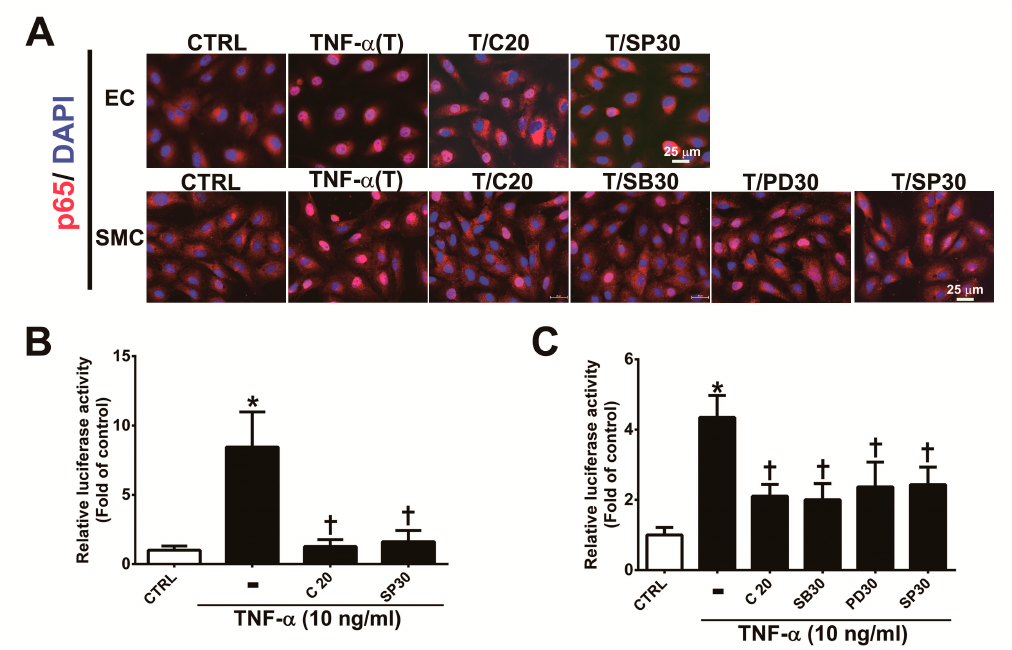
Figure 5. Corylin reduces the activation of NF- κ B p65 in TNF- α -treated HUVECs and VSMCs. ( A ) HUVECs were pretreated (1 h) with 20 µ M corylin (C20) or 30 nM SP600125 (SP30) and then incubated with 10 ng / mL TNF- α (T) for 15 min. VSMCs were pretreated (1 h) with 20 µ M corylin, 30 µ M SB203580 (SB30), 30 µ M PD98059 (PD30), or 30 nM SP600125 (SP30) and then incubated with 10 ng / mL TNF- α (T) for 15 min. Immunofluorescence staining was performed to examine the nuclear localization and expression level of phosphorylated NF- κ B p65 (P-p65). Nuclei were labeled with DAPI (blue). Scale bar = 25 µ m. ( B , C ) HUVECs and VSMCs were transfected with NF- κ B p65 luciferase reporter constructs, pretreated (1 h) with 20 µ M corylin (C20), 30 µ M SB203580 (SB30), 30 µ M PD98059 (PD30), or 30 nM SP600125 (SP30) and then incubated with 10 ng / mL TNF- α for 6 h. Total cell lysates were collected, and luciferase activity was detected. The data are shown as the mean ± SD. * p < 0.05 versus the untreated group (CTRL). † p < 0.05 versus the TNF- α -treated